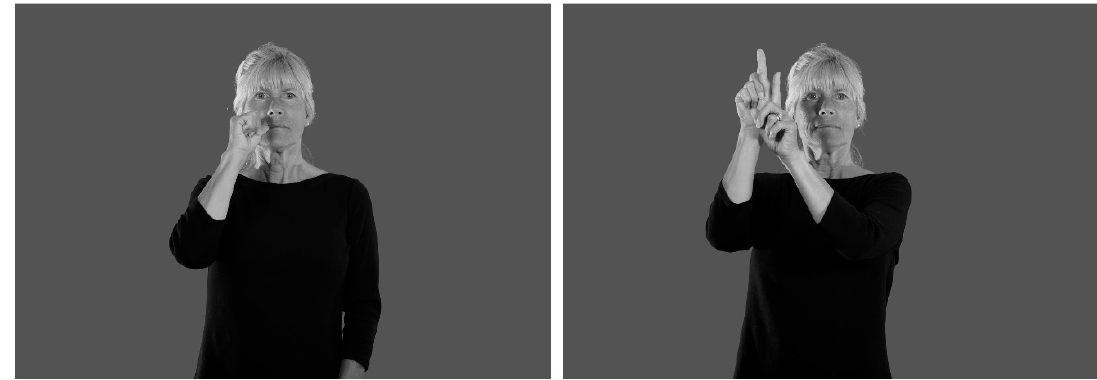
Figure 1. Example stimuli. A prime-target pair consisting of American Sign Language (ASL) signs with English rime translation ( bar–star